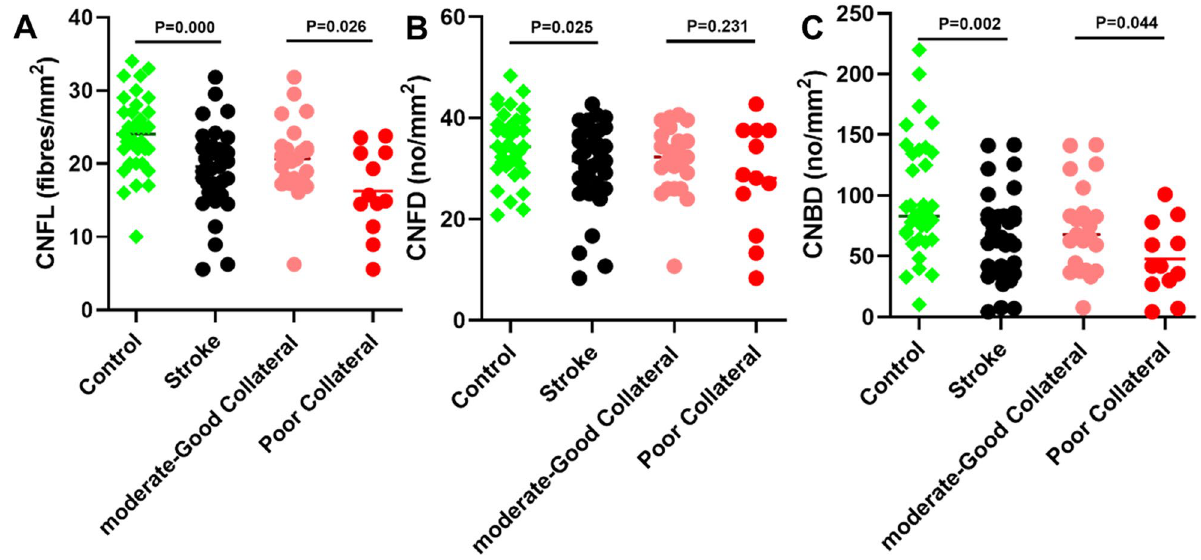
Figure 1. Dot plots of corneal nerve fiber parameters: ( A ) corneal nerve fiber length (CNFL), ( B ) corneal nerve fiber density (CNFD), ( C ) and corneal nerve branch density (CNBD), in controls, all stroke and stroke participants with poor compared to moderate-good collaterals.